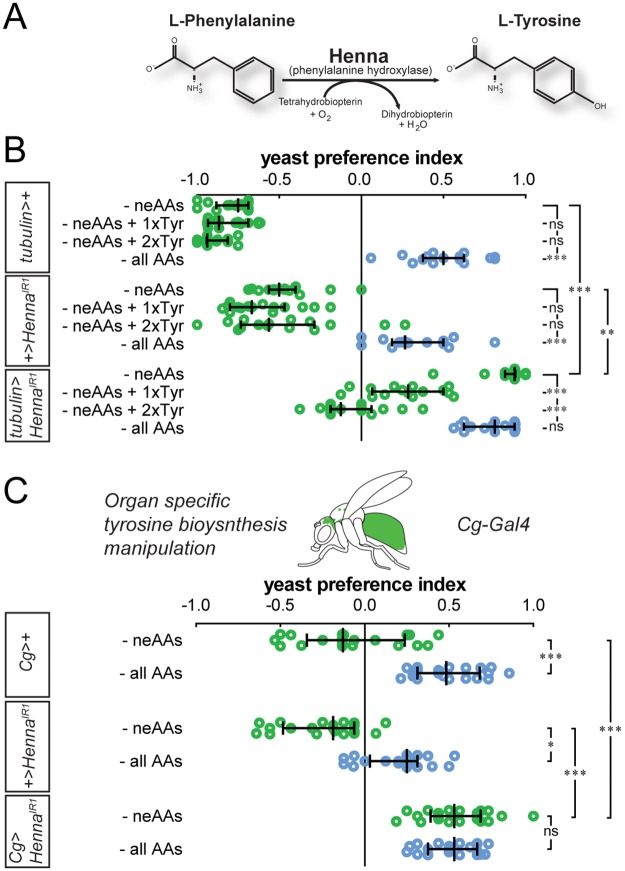
Loss of peripheral synthesis of nonessential amino acids (neAAs) increases yeast appetite.(A) Schematic depicting the biosynthesis of tyrosine (Tyr) in Drosophila. (B) Feeding preference of control and Henna whole-animal knockdown flies upon removal of all amino acids (AAs), all neAAs, or all neAAs with 1x and 2x Tyr added back. (C) Feeding preference of control and Henna fat body knockdown flies upon removal of either all neAAs or all AAs. (B and C) Circles represent yeast preference in single assays, with a line representing the median and whiskers representing the interquartile range. n = 15–20. Significance was tested using the Kruskal–Wallis test followed by Dunn’s multiple comparison test. Not significant (ns) p > 0.05, * p < 0.05, ** p < 0.01, *** p < 0.001. Underlying data used in this Fig are provided in S1 Data.